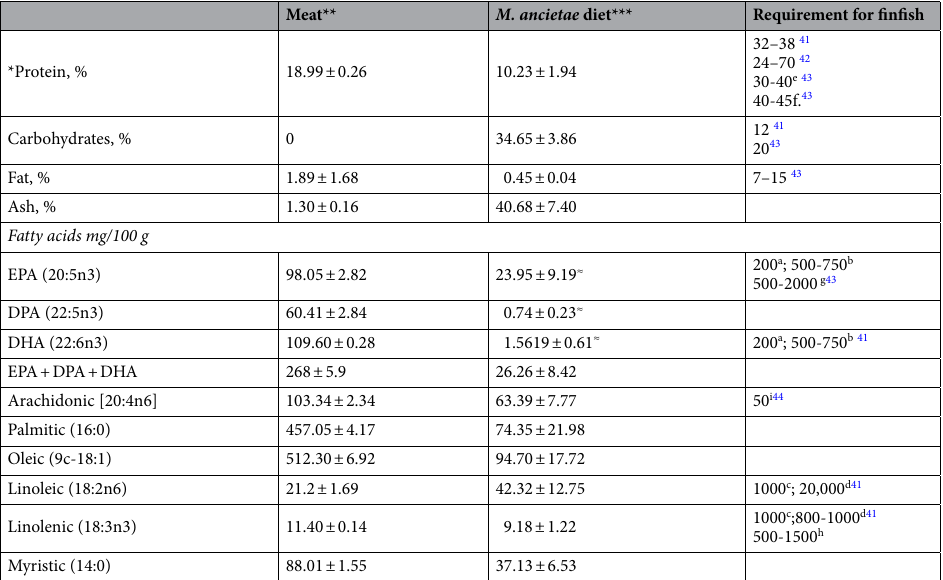
Table 5. Nutritional and fatty acid composition of the total lipid in meat and diet of adult specimens of Acha fish ( Medialuna ancietae ) compared with nutritional requirements for some finfish. * Kjeldahl crude protein = % N × 6.25. ** Values are based on the mean ± S.D., n = 3. *** Results are expressed on a "dry matter" basis. ≈ Dietary component with significant difference between individuals. P < 0.05. Values are based on the trout. e Tilapia, f Trout and other marine finfish, g Marine fish, h Freshwater fish. i Malabar red